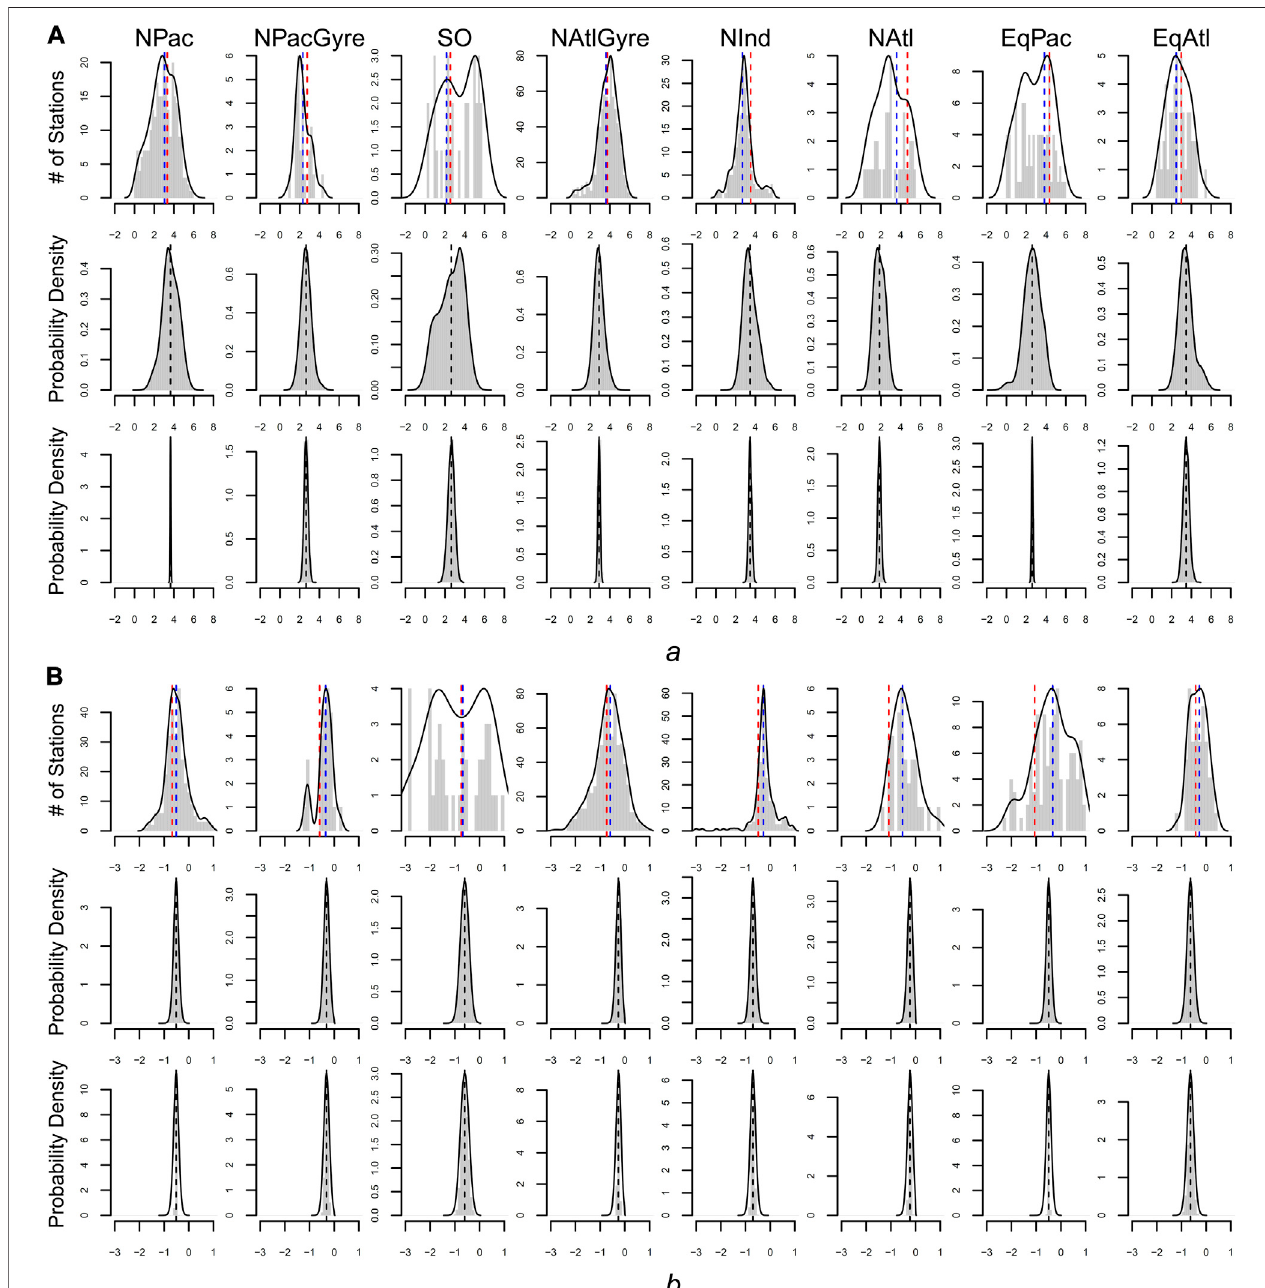
distribution).The red dashed lineisthebiome-levelestimate via dataaggregation. Themiddlerows givethedistributionofstation-levelparametersforthehierarchical fi t. Bottom rows give the distribution for the biome-level parameters for the hierarchical fi